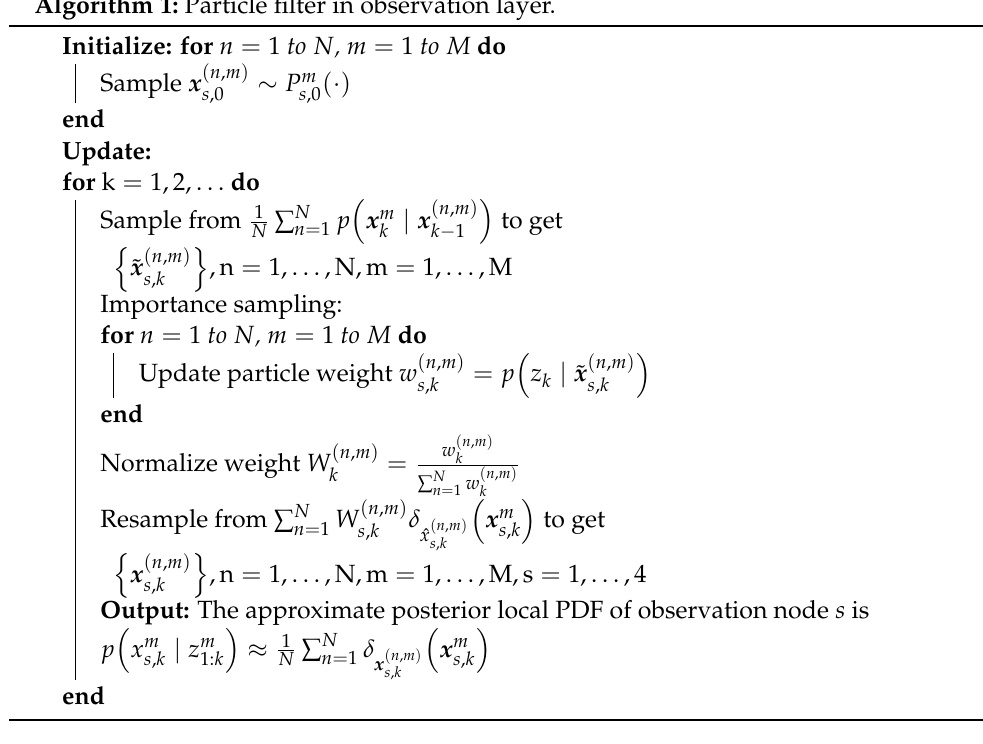
Algorithm 1: Particle filter in observation